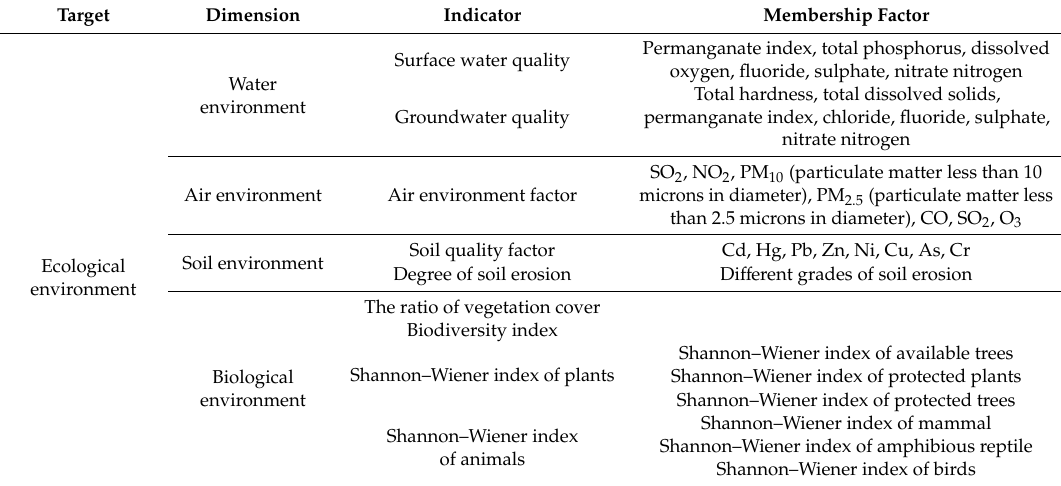
Table 1. Ecological environment evaluation indicator system for a forest ecosystem nature